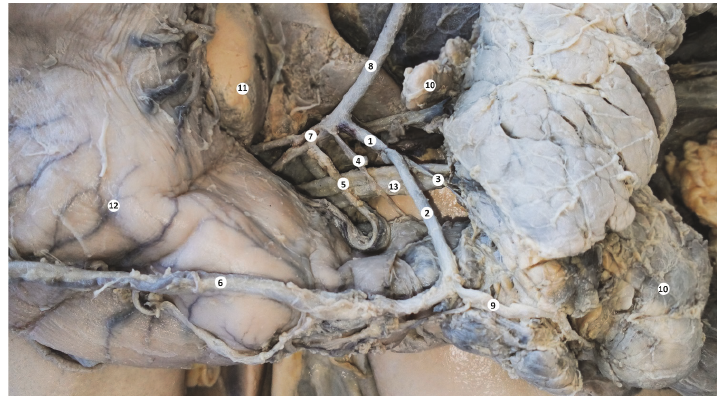
Figure 5: The branchesof pancreaticoduodenalartery.Macrospecimen(female,63 years old). 1: gastroduodenalartery,2: right gastroepiploic artery, 3: superior posterior pancreaticoduodenal artery, 4: superior duodenal artery, 5: right gastric artery, 6: right gastroepiploic artery, 7: proper hepatic artery, 8: common hepatic artery, 9: superior anterior pancreaticoduodenal artery, 10: pancreas, 11: liver, 12: stomach, and 13: common bile